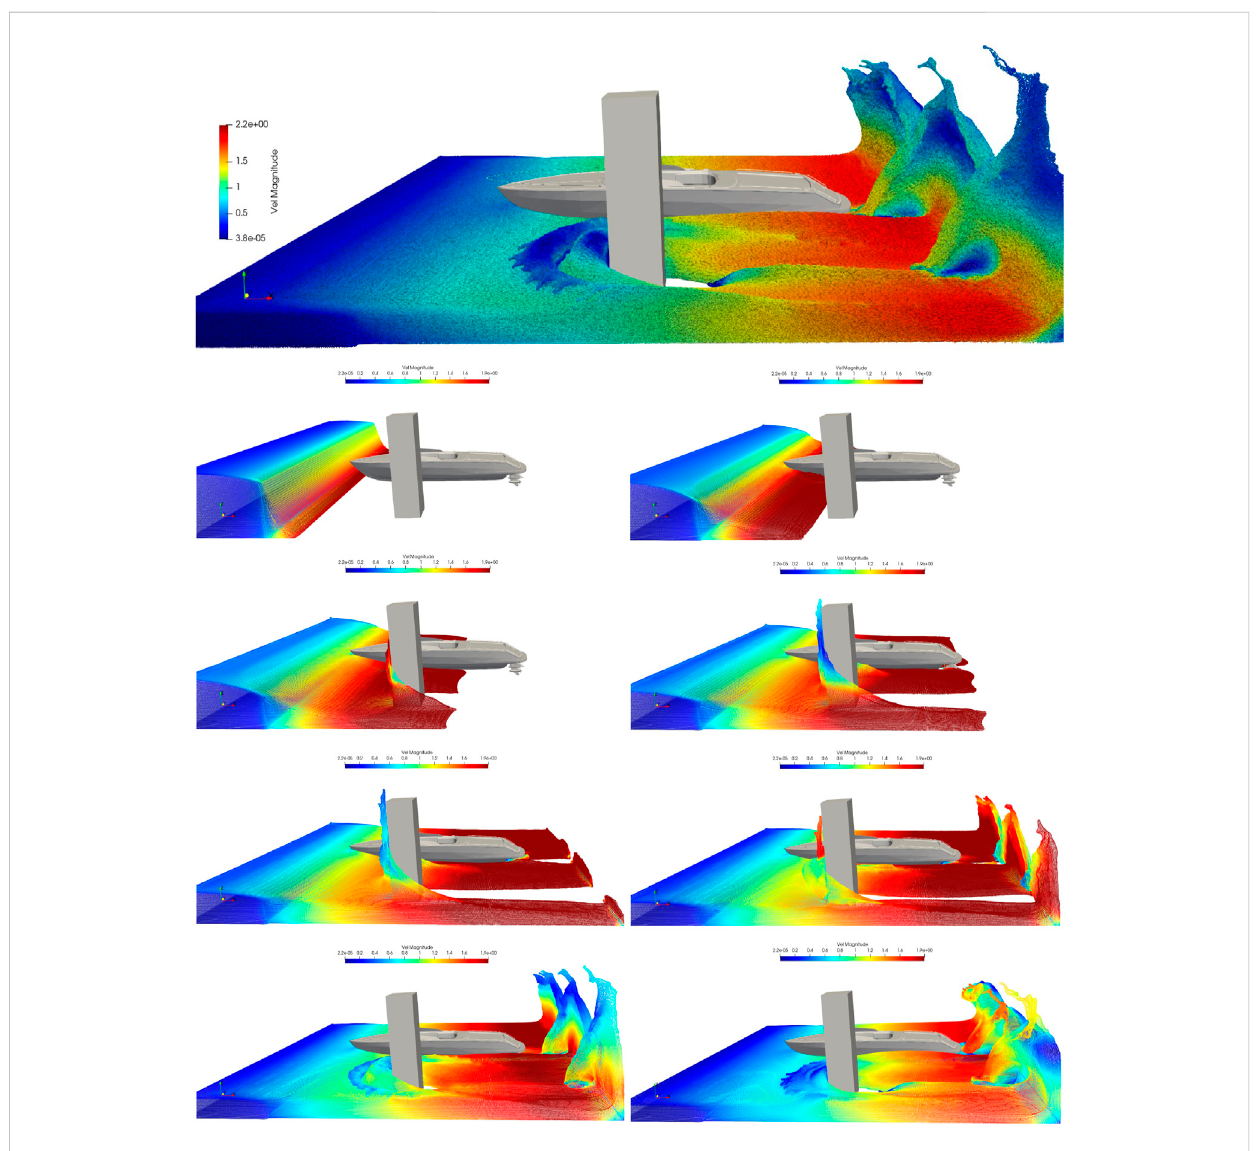
FIGURE 17 Simulation procedure of water fl ow through ship and square